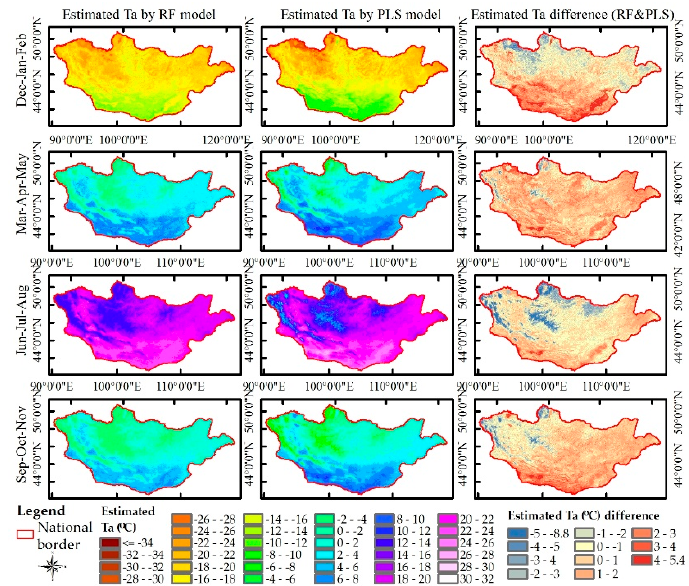
Figure 8. Estimated average Ta per season using LSTd, LSTn, and elevation as predictor variables. ( a ) Spatial maps of seasonal-average Ta over Mongolia at 1 km spatial resolution using the RF (first column) and partial least squares (PLS) regression models (second column). In the last column, the difference between the two model outputs is shown.